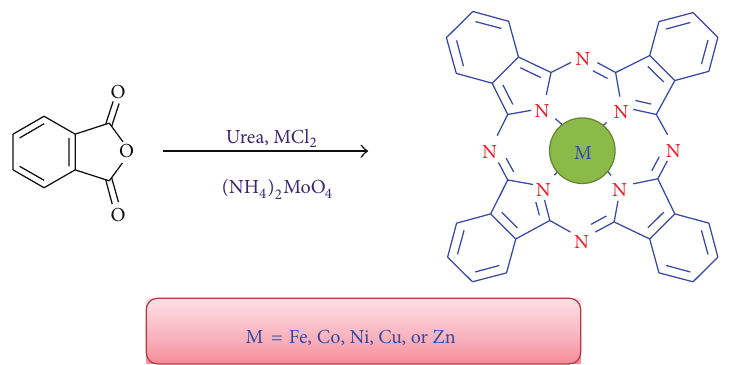
Figure 1: The reaction of solid-phase synthesis of